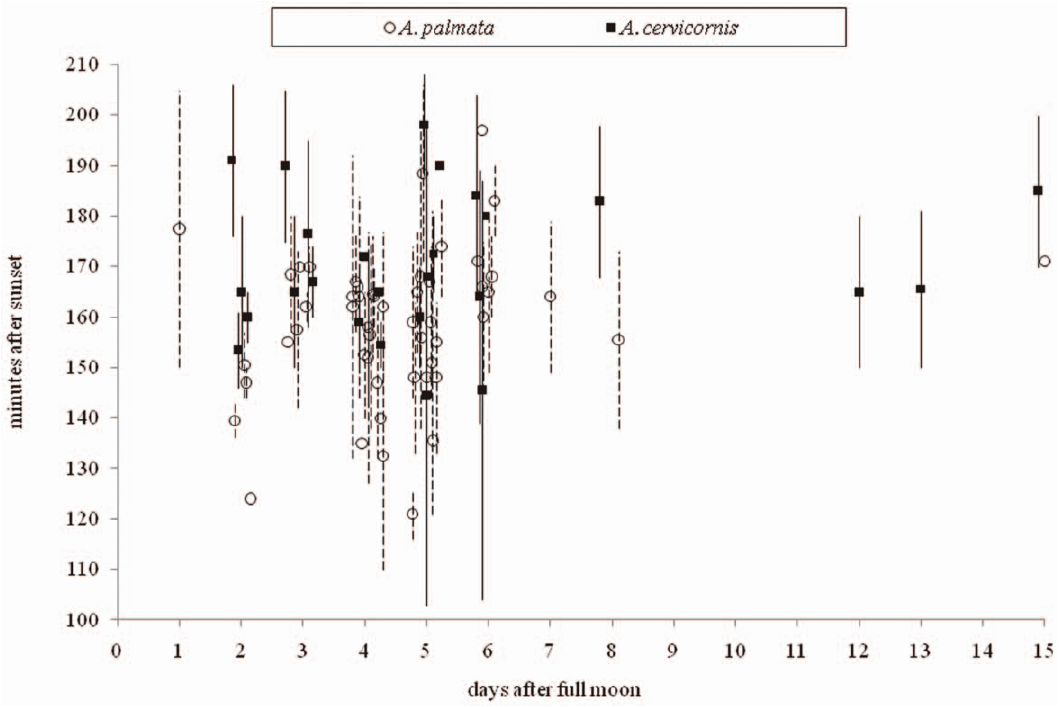
Figure 1. Spawning times for acroporids corals in Florida and the Caribbean. These data are taken from personal observations, publications, and postings on the coral-list server. Lines above and below the mean (symbols) indicate the given range of spawn times for A. palmata (dashed lines) and A. cervicornis (solid lines).